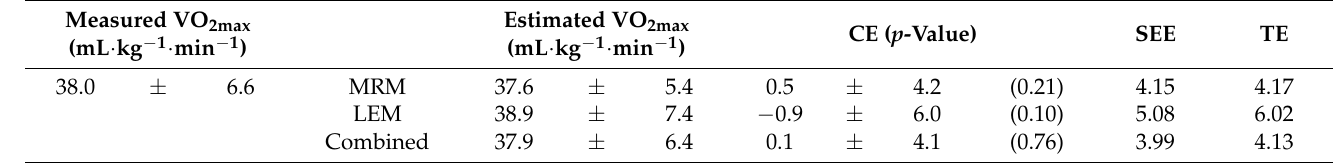
Table 2. Measured versus estimated VO 2max and error statistics ( N = ．